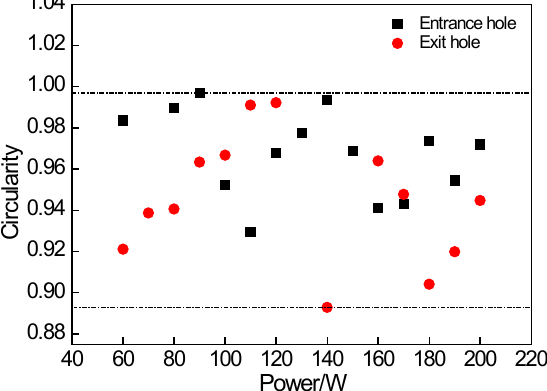
Figure 5. Variation of circularities of entrance and exit circles with laser power.